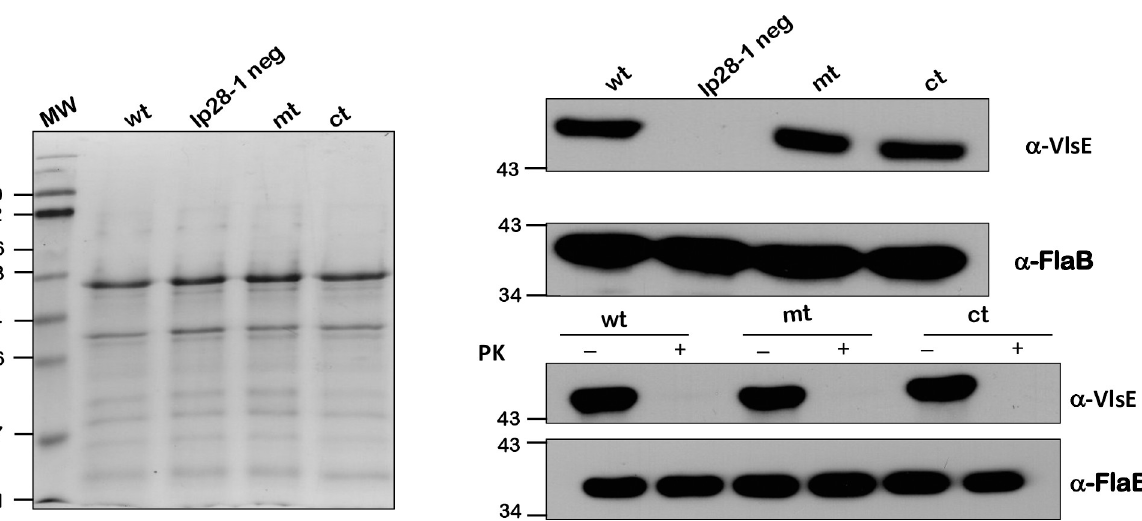
Fig 17. Levels of VlsE in wt, mt and ct strains. Coomassie blue stained SDS-PAGE gel of proteins from borrelial strains (wt (B31-A3), lp28-1 negative clone (B31-A3), mt and ct) grown under 32˚C/pH7.6 in BSKII medium ( A ). Immunoblot analysis of lysates from the above borrelial strains with anti-VlsE serum ( B ) and following Proteinase K treatment of borrelial strains ( C ). Immunoblots using FlaB antibodies served as controls in both B and C . Molecular weight markers in kilodaltons are indicated to the left.